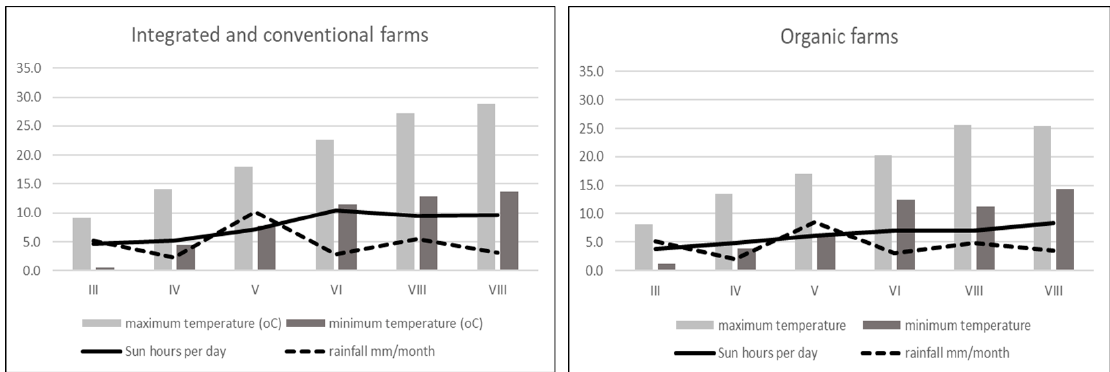
Figure 1. Weather conditions in experimental farms (organic, integrated and conventional) 2013 in time of strawberry fruits development.